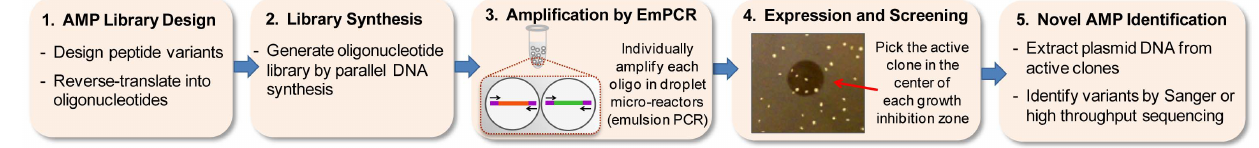
Figure 1. Diagram of the five-step process for the construction and screening of AMP libraries.